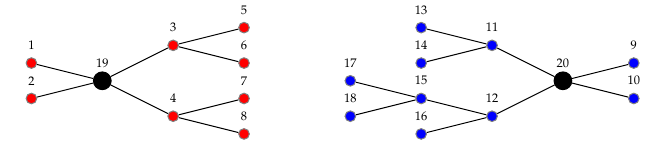
Figure 2. Wind farm layout